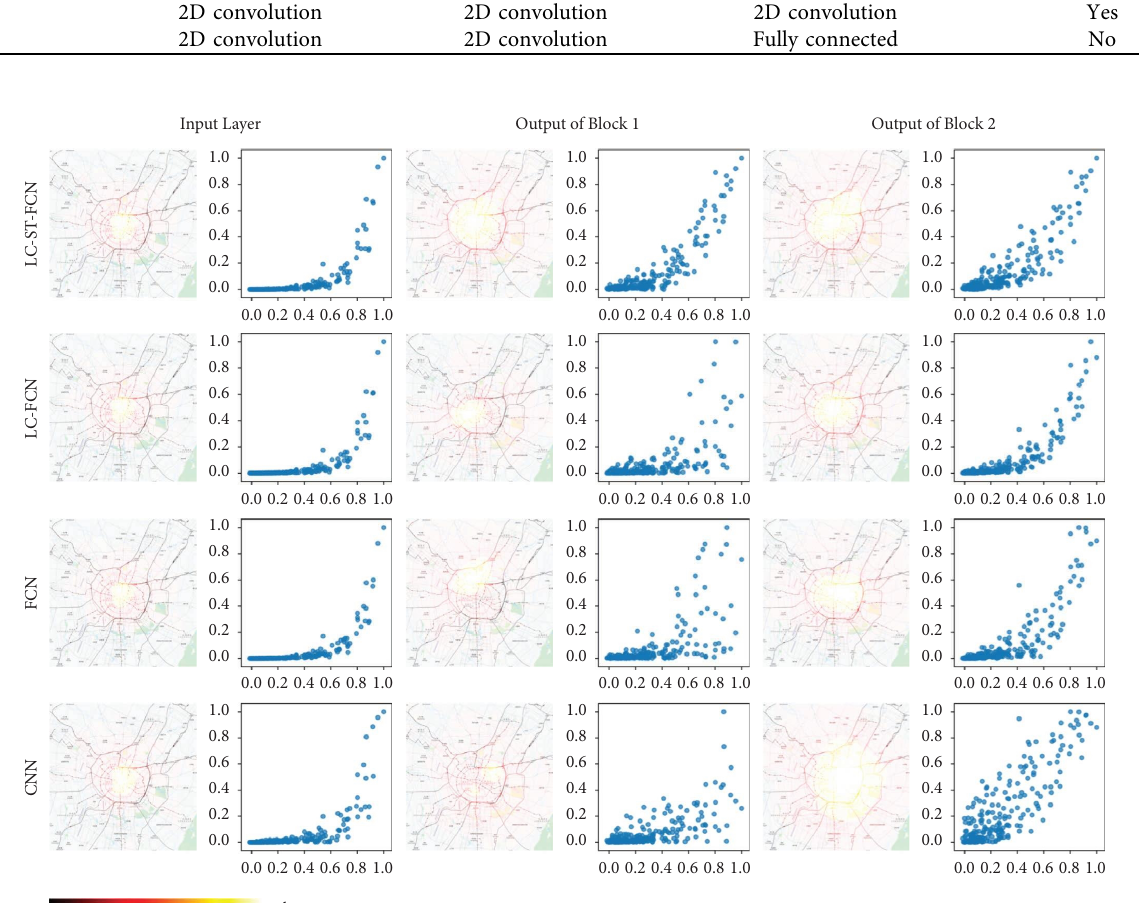
Figure 8: Te activation maps of hidden layers.